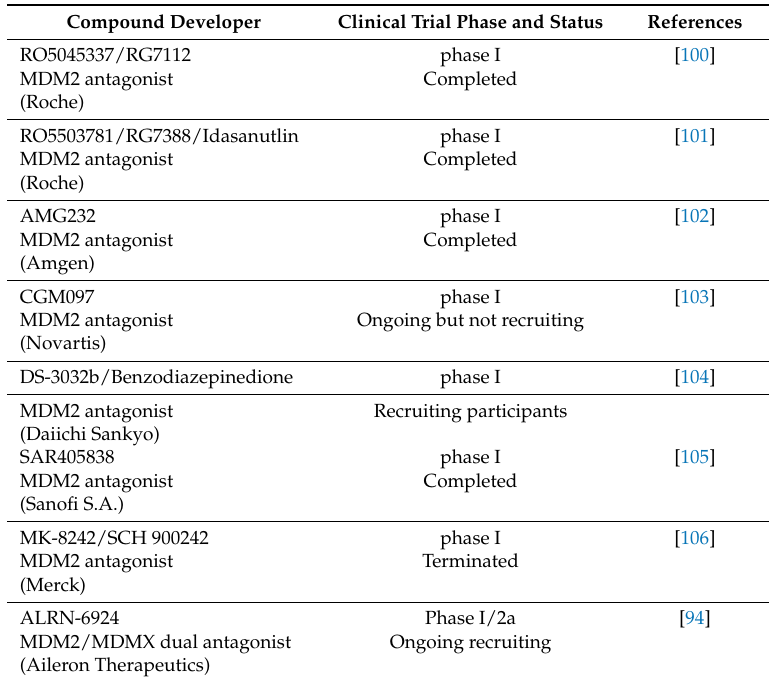
Table 4. List of MDM2-p53 inhibitors in previous or current clinical trials are listed MDM2 Inhibitors in Clinical Trials